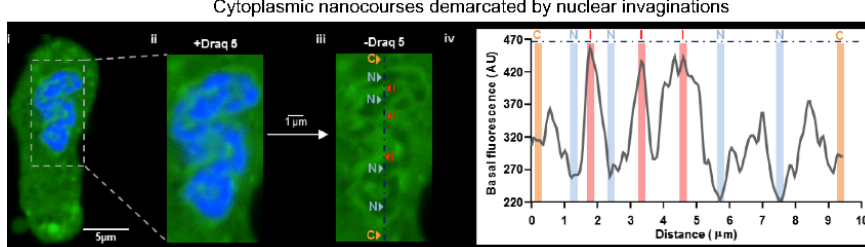
Figure 12. Fluo-4 fluorescence (green) identifies cytoplasmic nanocourses within the boundary of the Draq5 labelled nucleus (blue) of a confocal Z section through a pulmonary arterial myocyte ( left hand panels i-iii). A spectral intensity plot across the nucleus ( right hand panel iv) shows that nanocourses within nuclear invaginations (NI) exhibit higher levels of fluorescence than the nucleoplasm (N), and cytoplasm (C) identified by the dashed line in panel iii.